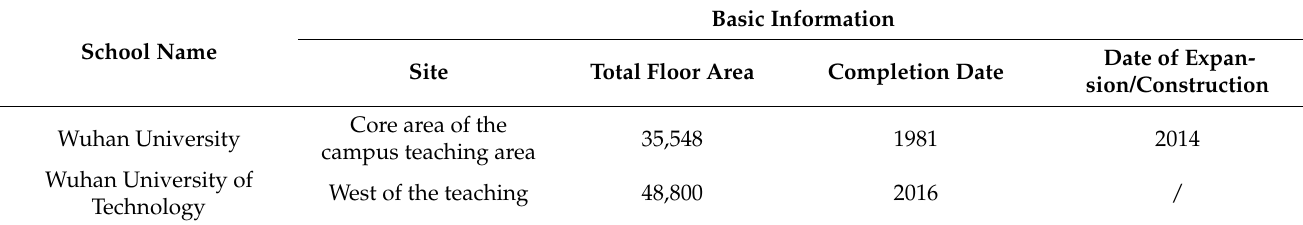
Table 3. Basic information about the libraries of the two universities.